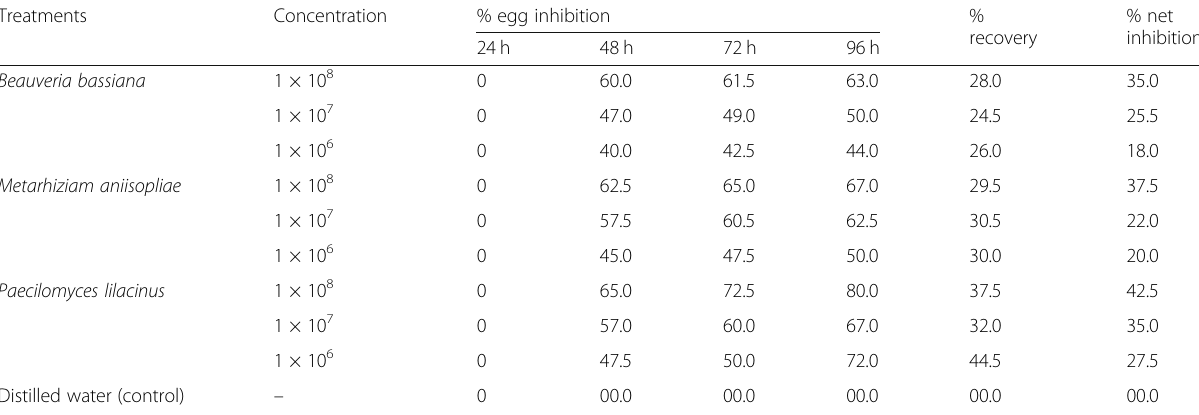
Table 2 Percentages of egg inhibition of root-knot nematode, Meloidogyne incognita , as influenced by three spore concentrations from Beauveria bassiana , Metarhiziam aniisopliae , and Paecilomyces lilacinus after 24, 48, 72, and 96 h exposure Treatments